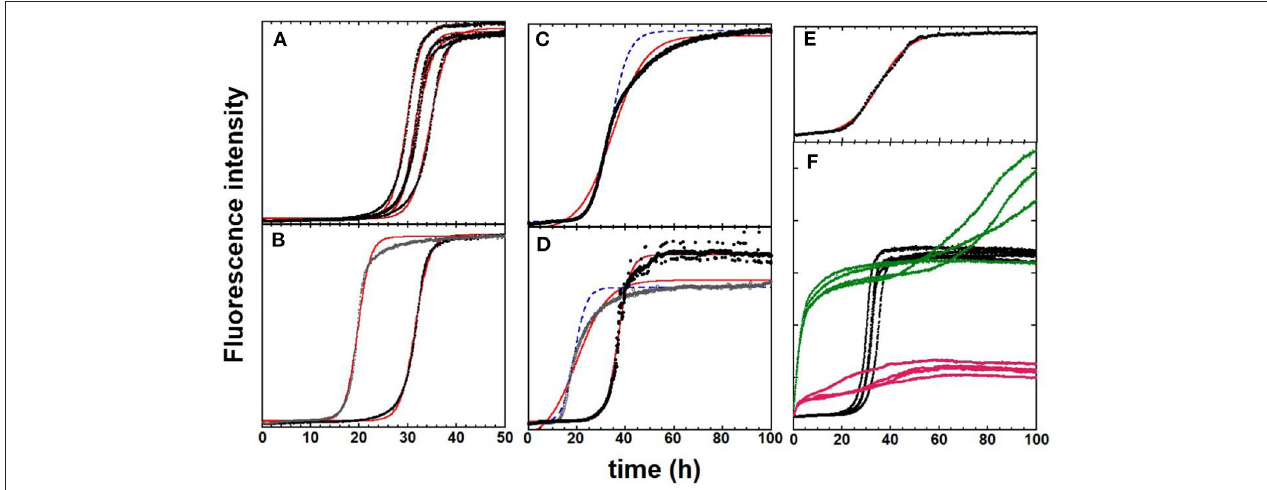
FIGURE 2 | ThT fluorescence experiments to monitor the kinetics of A β 40 aggregation in black [fits according to Equation (1) are in red. In some cases, curves obtained with manual adjustment of parameters are shown in dashed blue lines]. (A) The “ideal” case with four replicates in parallel from the same batch 1. (B) Impact of size-exclusion-chromatography fractioning. The two representative traces come from two fractions from the central part of the chromatography peak of batch 1. (A,C,E) Impact of peptide batch. Identical experimental conditions were used for three different batches. The s-shape curve is sigmoidal ( A , batch 1), asymmetric ( C , batch 2), and doubly sigmoidal ( E , batch 3). The fits and manual reproduction of the experimental curves are not satisfactory for batches 2 and 3. (D) Impact of identical experimental protocol repetition with the same batch: Batch 4, but performed on different days (black vs. gray dots). (F) Impact of the addition of metal ions. Apo-A β 40 (batch 1, black dots) with one mol equivalence of Zn(II) added (green) and with one mol equivalence of Cu(II) added (pink). The fluorescence values of all curves are directly comparable to each other. General conditions: A β 40 at 20 µ M in 50mM Hepes buffer, pH 7.4. [ThT] = 10 µ M. Except for (A,F) , in which one representative of each replicate is shown while all the replicates are given in SI with parameters deduced from the fitted curves. Data are in-house data unpublished except for (A,F) , from Conte-Daban et al. (2018).